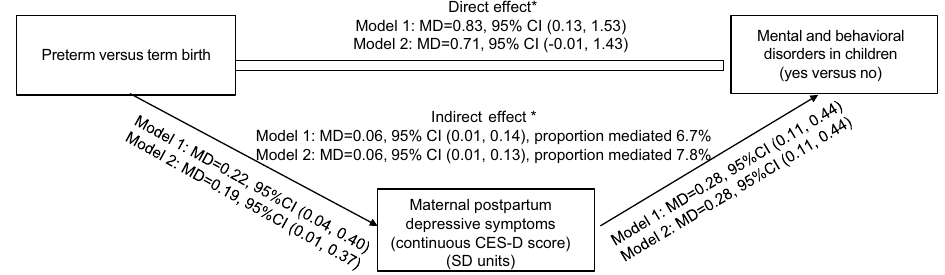
Figure 1. Mediation analysis showing that the effect of preterm birth on mental and behavioral disorders in children until age 8.4–12.8 years, is partially mediated via maternal postpartum depressive symptoms. Model 1 refers to unadjusted associations and Model 2 to associations adjusted for maternal age at delivery, education, smoking and/or alcohol use at any time during pregnancy, delivery mode and child sex and age at diagnosis. The effects are shown as mean differences (MD) and their 95% Confidence Intervals (95%